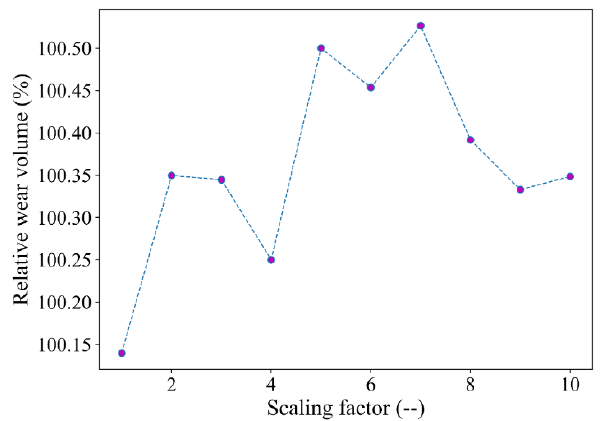
Figure 7. Comparison between the simulation results and Archard wear model.